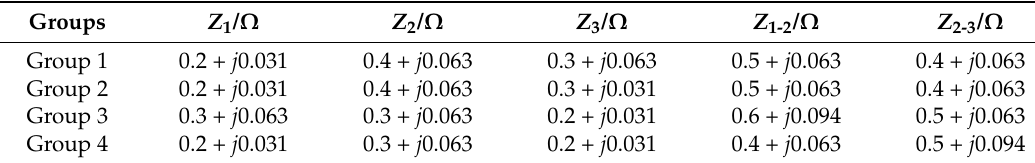
Table 2. Parameters of line impedance in different groups.